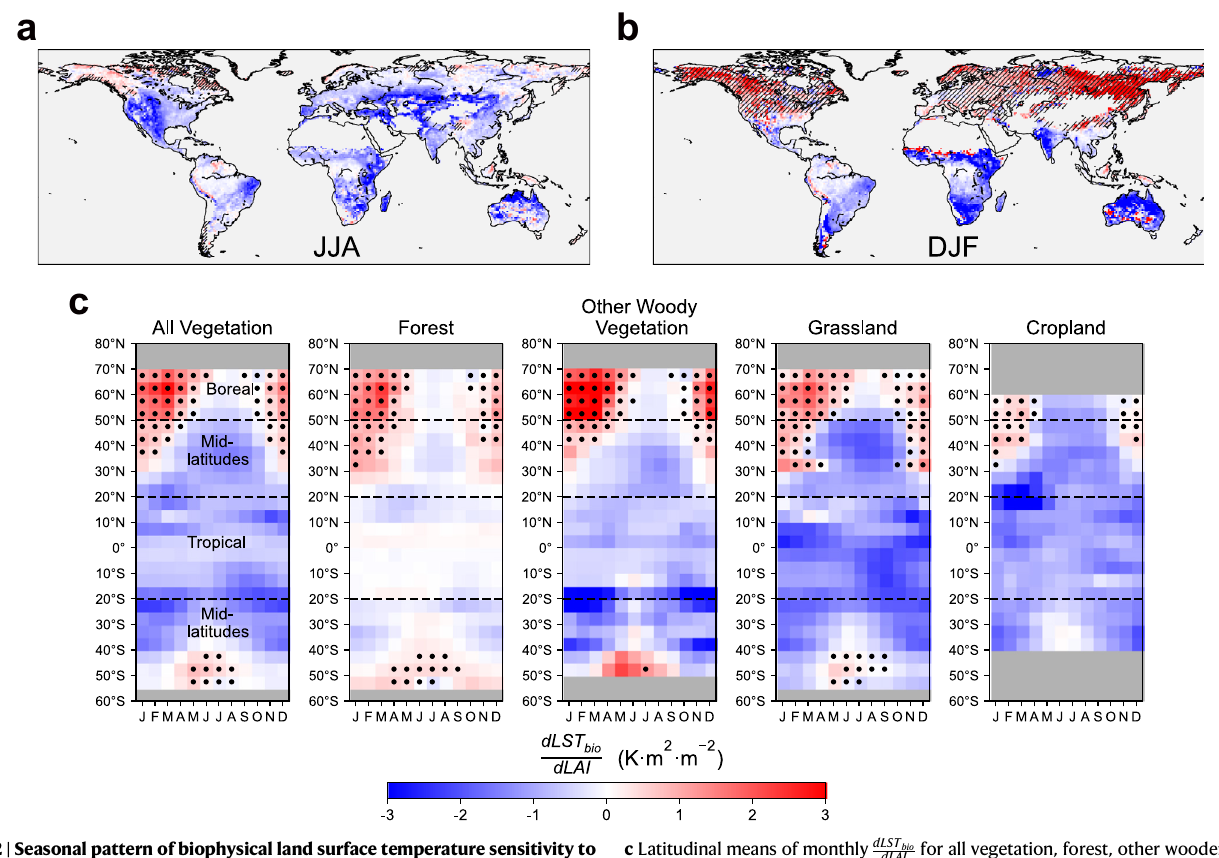
Fig. 2 | Seasonal pattern ofbiophysicalland surface temperature sensitivityto leaf area index ð dLS T bio dLAI Þ . a Spatial map of dLST bio dLAI in Northern Hemisphere summer (JJA, June to August) and ( b ) in Northern Hemisphere winter (December to Feb- ruary). The shaded area indicates the mean snow cover percentage larger than 1%.